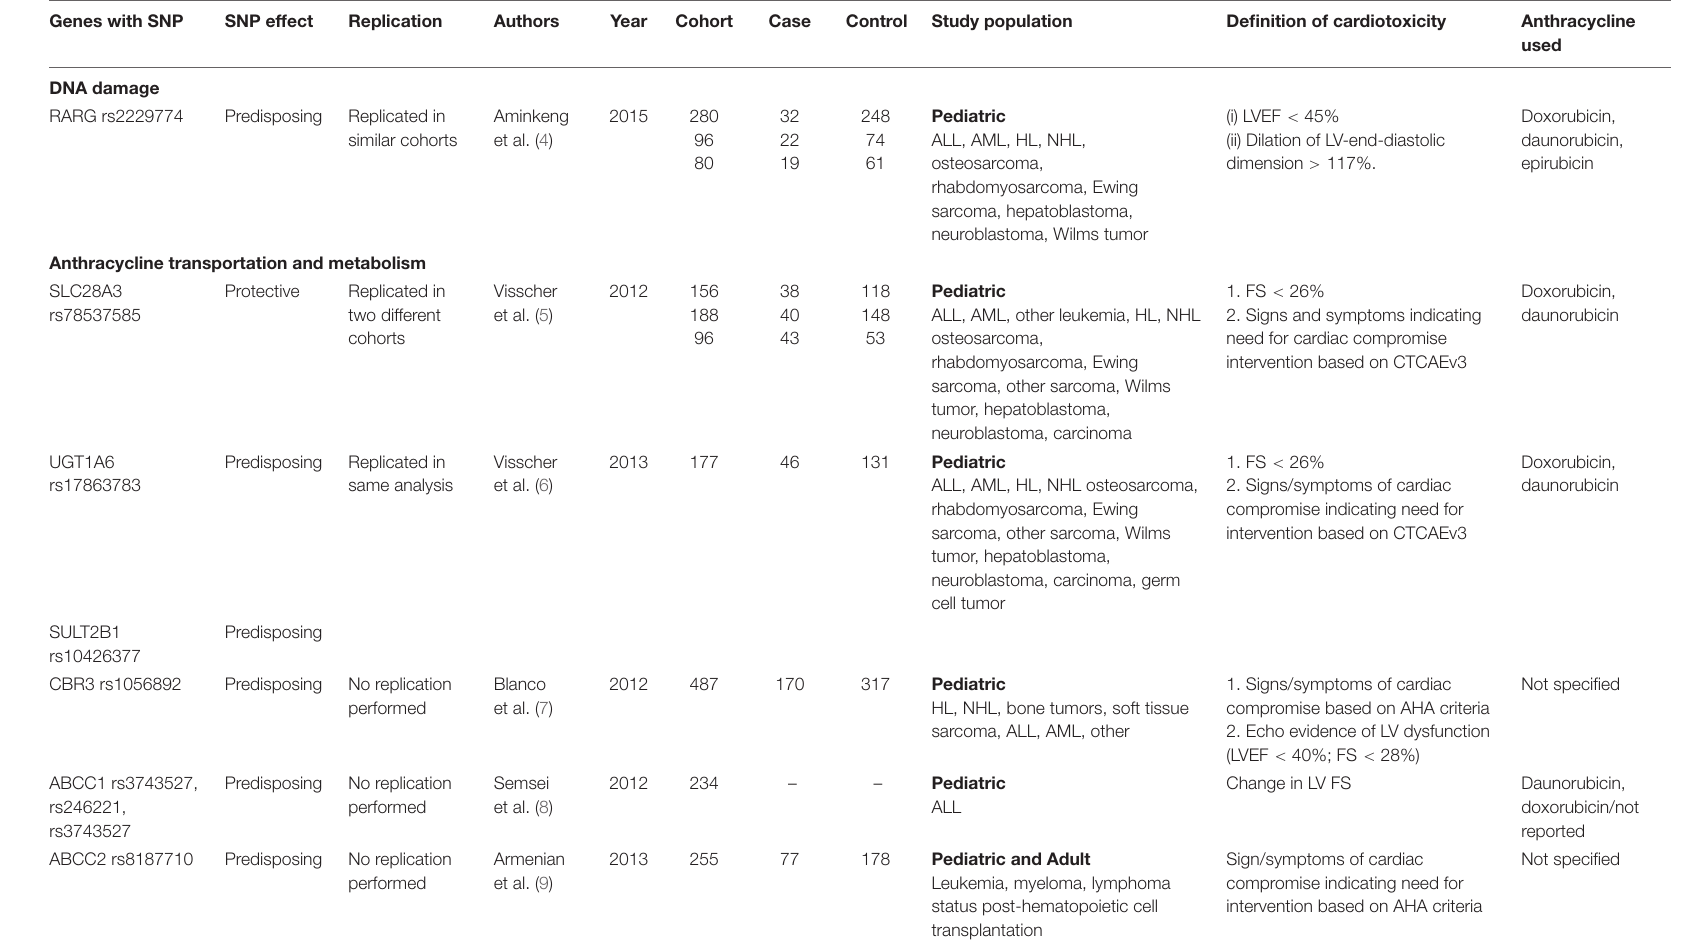
TABLE 1 | Summary of studies investigating the role of genetic modifiers implicated in anthracycline-associated cardiotoxicity. Genes with